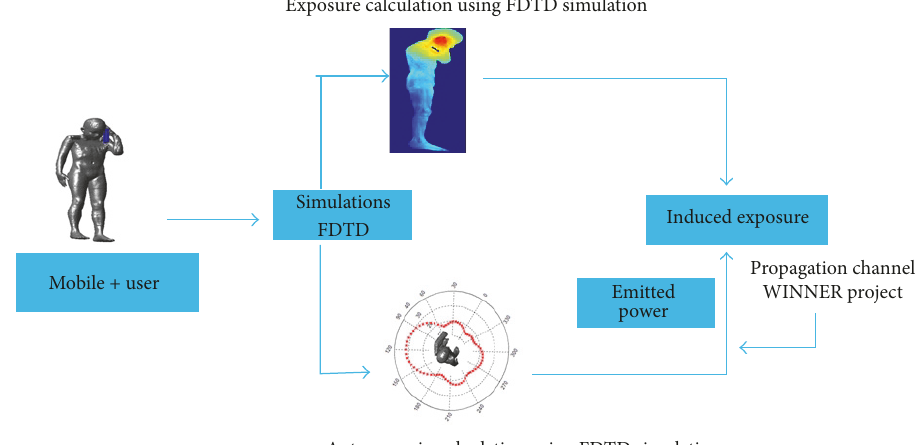
Figure 6: Flowchart of the subroutine for the characterization of the uplink exposure.